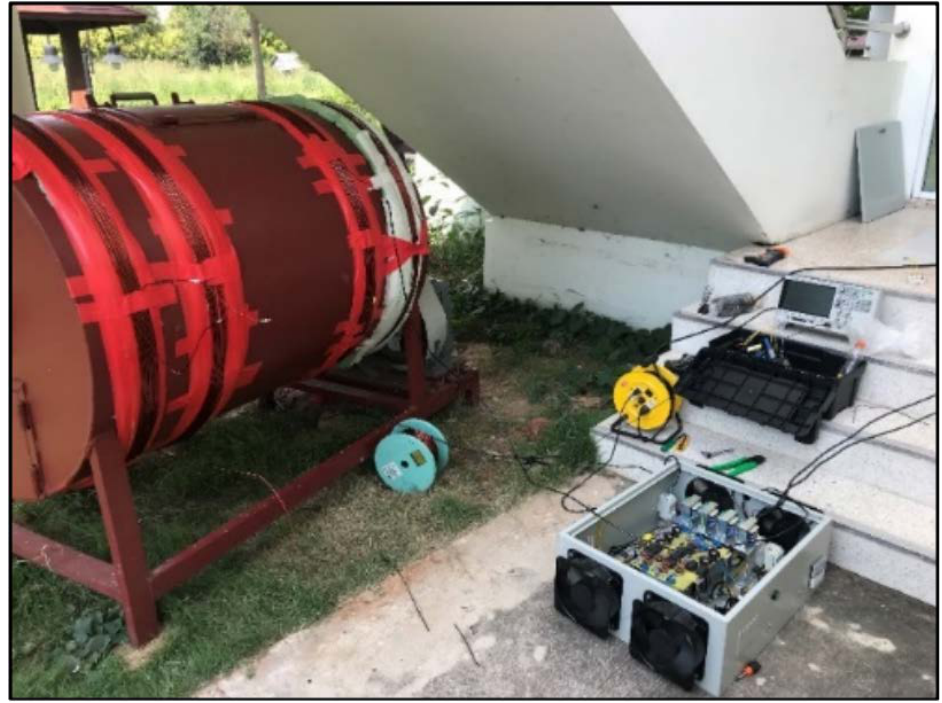
Figure 10. All four sets of copper wire wrapped around the bioreactor. When the copper wire is wound around a total of four groups of cans, the inductor value of each coil should be as similar as possible: about 190. A mini-Henry was used for all four heaters. This machine covers the tank with heat-resistant fibers to retain heat and prevent heat from entering from the outside, as shown in Figure 11.